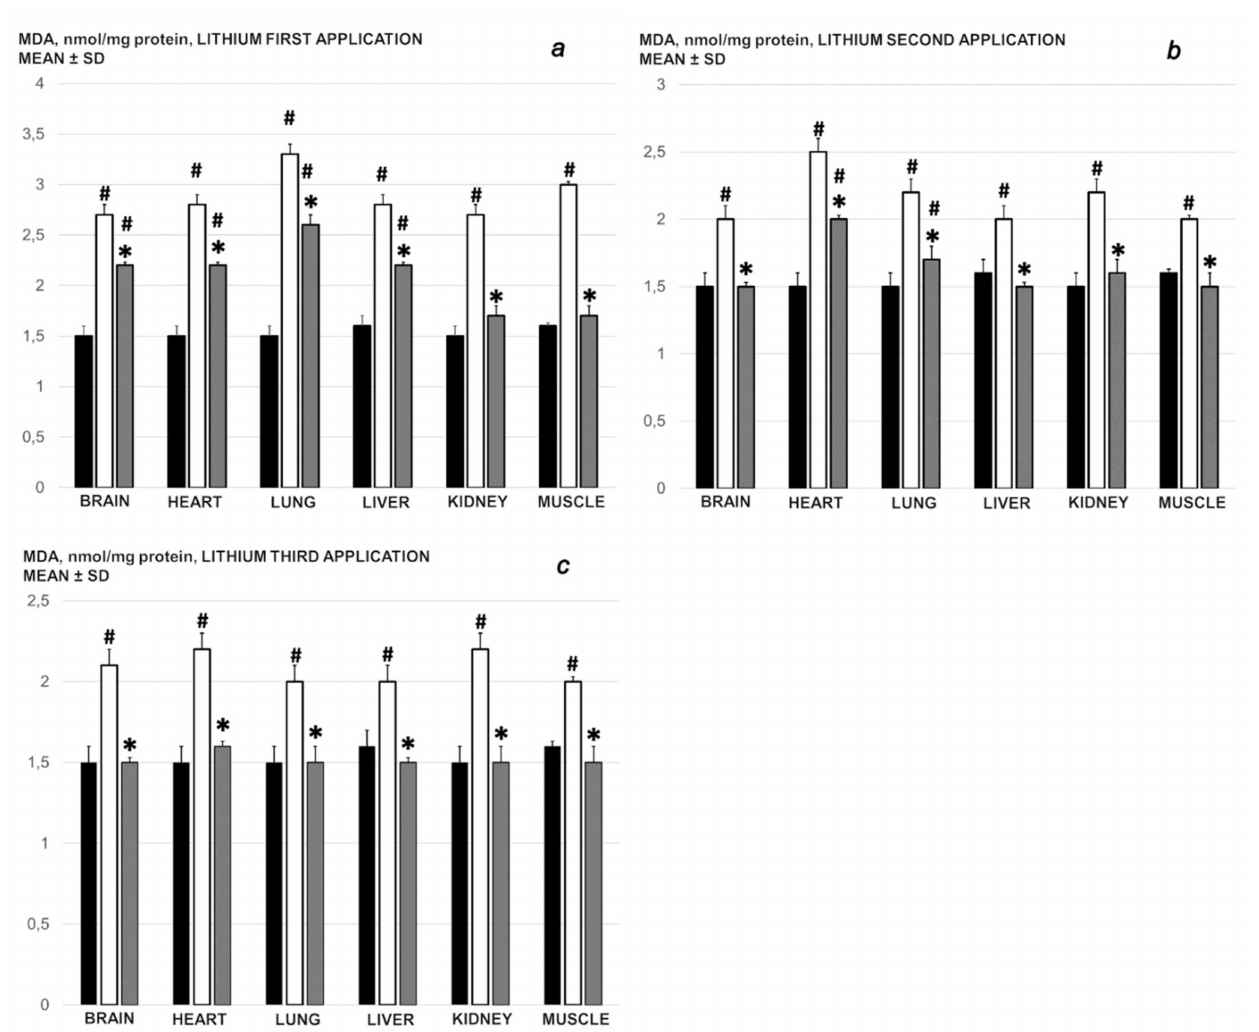
Figure 18. Oxidative stress (MDA, nmol/g protein), in healthy rats (black bars) and in the lithium-treated rats after the first ( a ), second ( b ), and third ( c ) lithium administration (500 mg/kg/day intraperitoneally for 3 consecutive days). BPC 157 10 ng/kg (dark gray bars) or saline 5 mL/kg (white bars) given intraperitoneally after each of the three lithium administrations. Six rats/group/interval. Means ± SD, # p < 0.05, at least vs. healthy; * p < 0.05, at least vs.